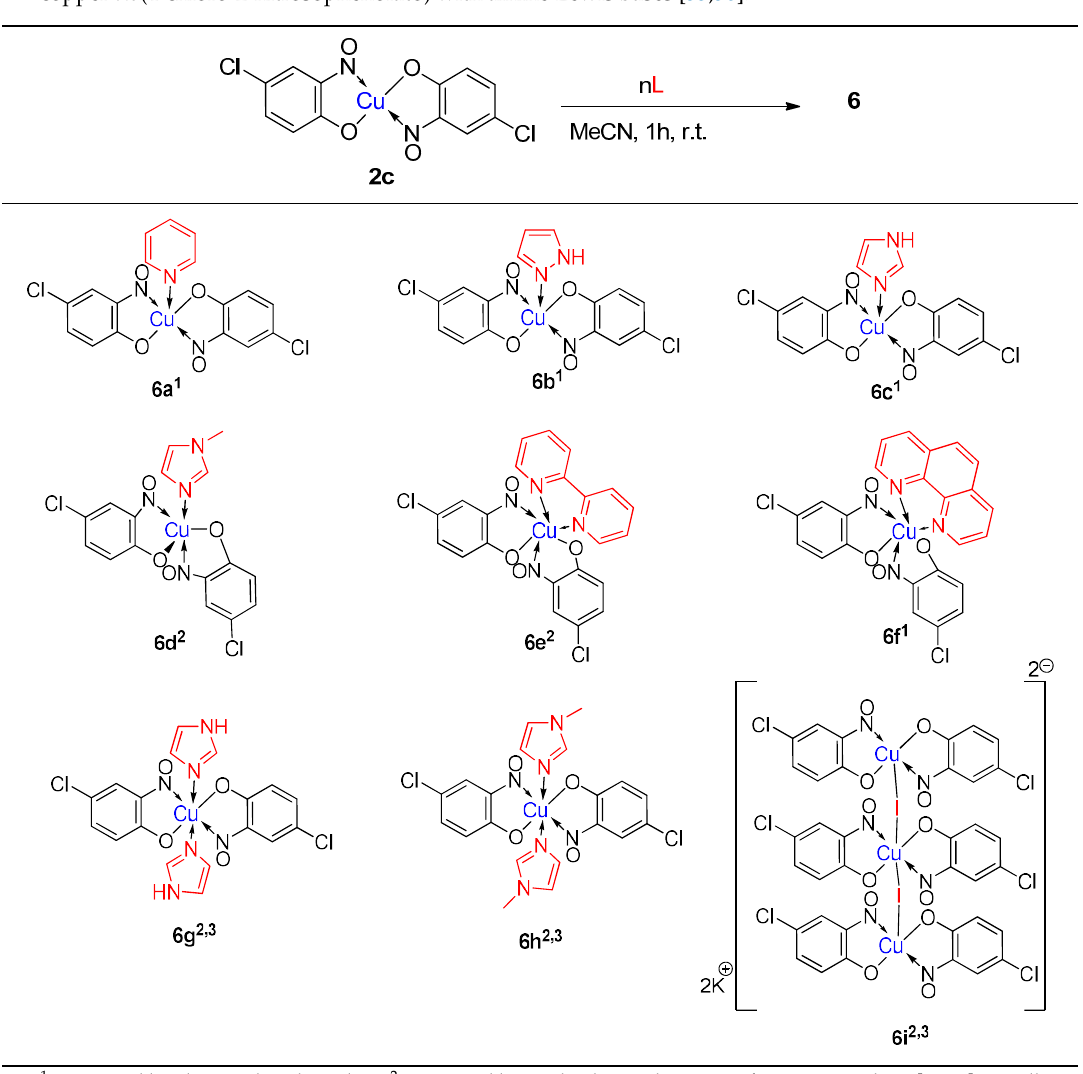
Table 2. A range of derivatised complexes generated by Castellani and co-workers, starting from